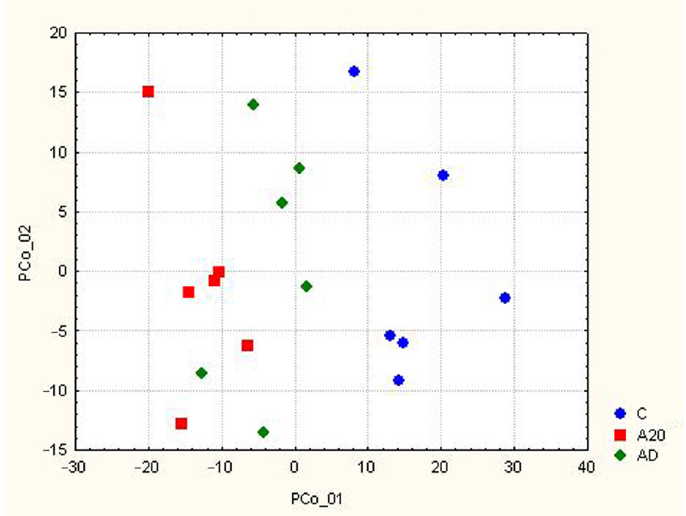
Figure 1. Differences in the transcription profile of the hippocampus between winners and control animals (principal coordinate analysis using Euclidean distances). C: Control mice without the ex- perience of agonistic interactions; A20: males with consecutive 20 days of wins in the daily agonistic interactions; AD: A20 mice after subsequent 14 days of fighting deprivation. agonistic interactions; AD: A20 mice after subsequent 14 days of fighting